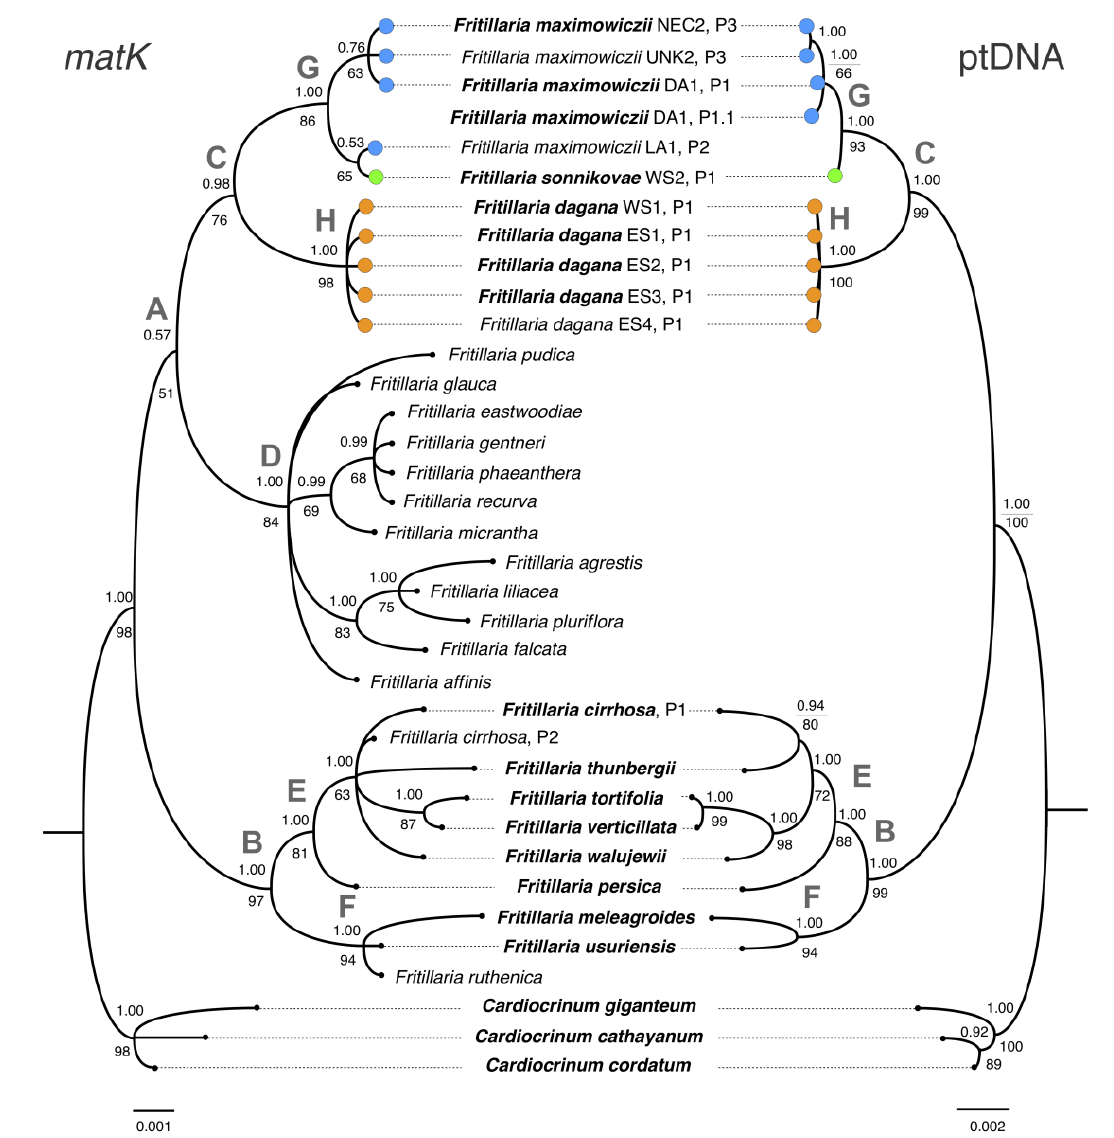
Figure 4. BI phylogram of ptDNA based on the 50% majority-rule consensus tree. Color patterns and names correspond to those in Figure 1 (UNK2 indicates unknown locality). Posterior probabilities are indicated above branches, bootstrap values for the corresponding clades on the ML tree (if relevant) below the branches. Capital letters at the nodes correspond to the groups discussed in the text and those in Figure 2. The plastotypes used in the subsequent joint ITS + ptDNA analysis are indicated in bold. Scale bar indicates the number of expected changes (substitutions or/and indels) per site corresponding to the unit of branch length.